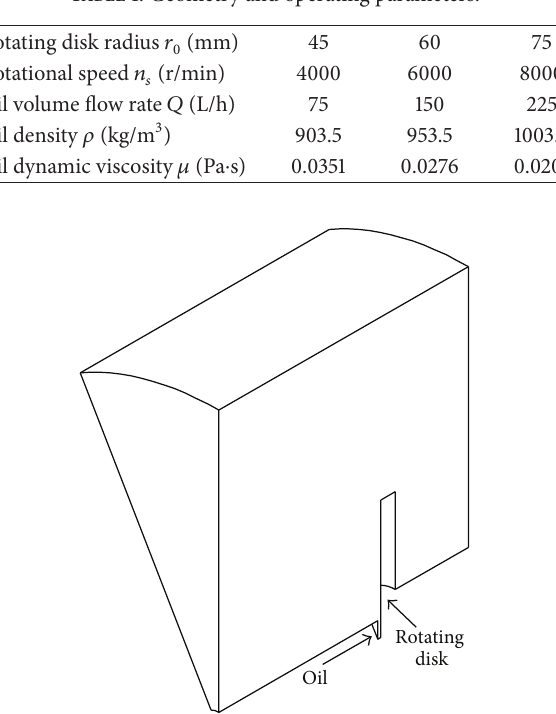
Table 1: Geometry and operating parameters.